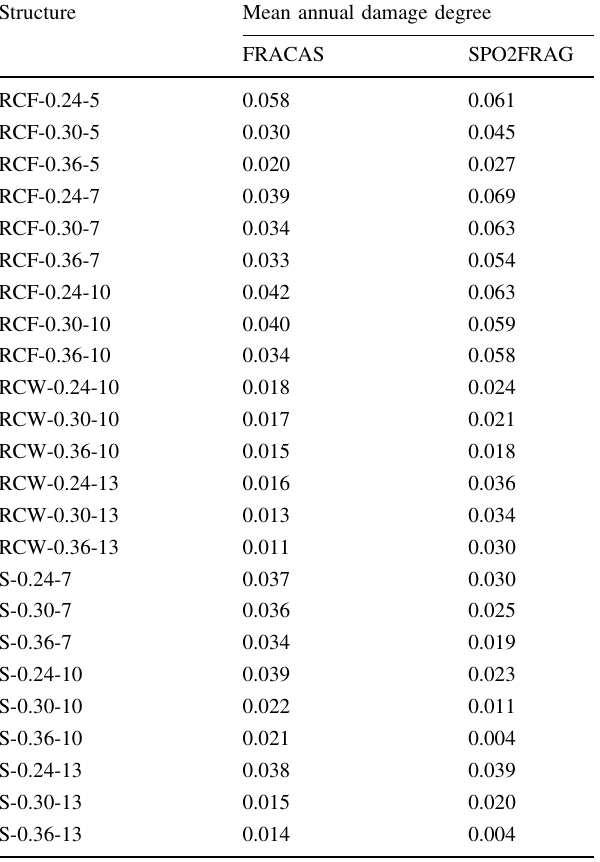
Table 3 Comparison of the mean annual damage degrees computed for reinforced concrete (RC) and steel (S) structures in Bucharest, Romania, using the FRACAS and SPO2FRAG approaches Structure